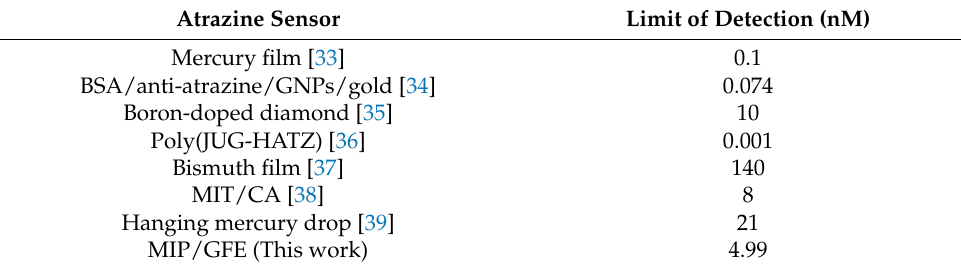
Table 9. Comparison of the performance of various atrazine